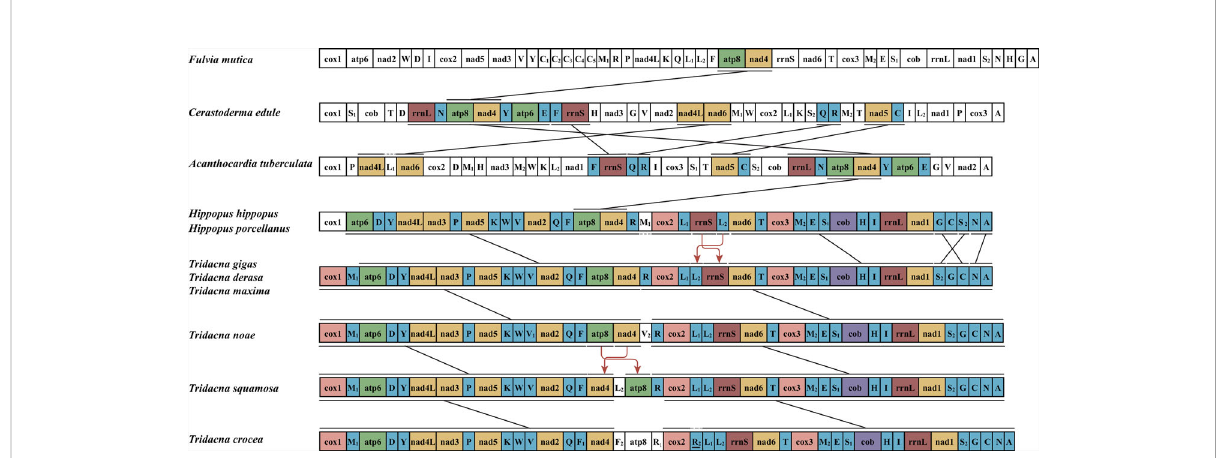
FIGURE 2 Mitochondrial genome rearrangements in Tridacninae and representatives from Veneroida species (All genes are transcribed from left-to-right. The bars show identical gene blocks. The arrows indicate gene translocation. The non-coding regions are not presented and gene segments are not drawn to